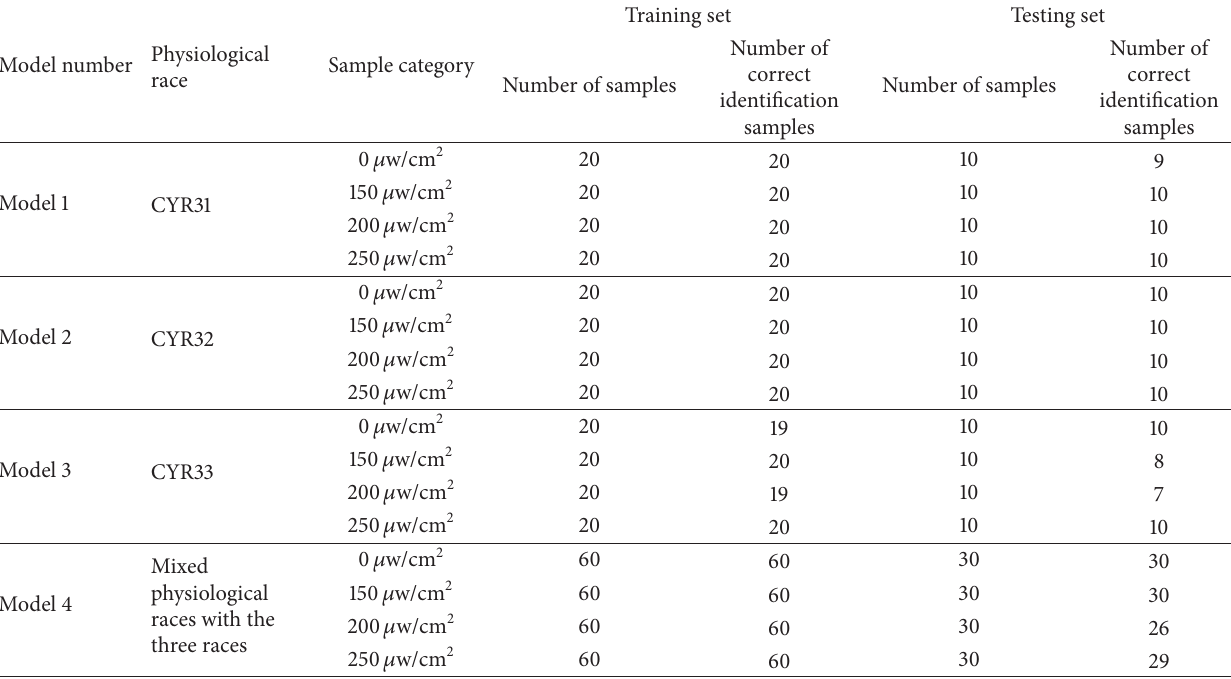
Table 2: The UV-B intensity identification results of SVM models for CYR31, CYR32, CYR33, and mixed physiological races with the three races, respectively.